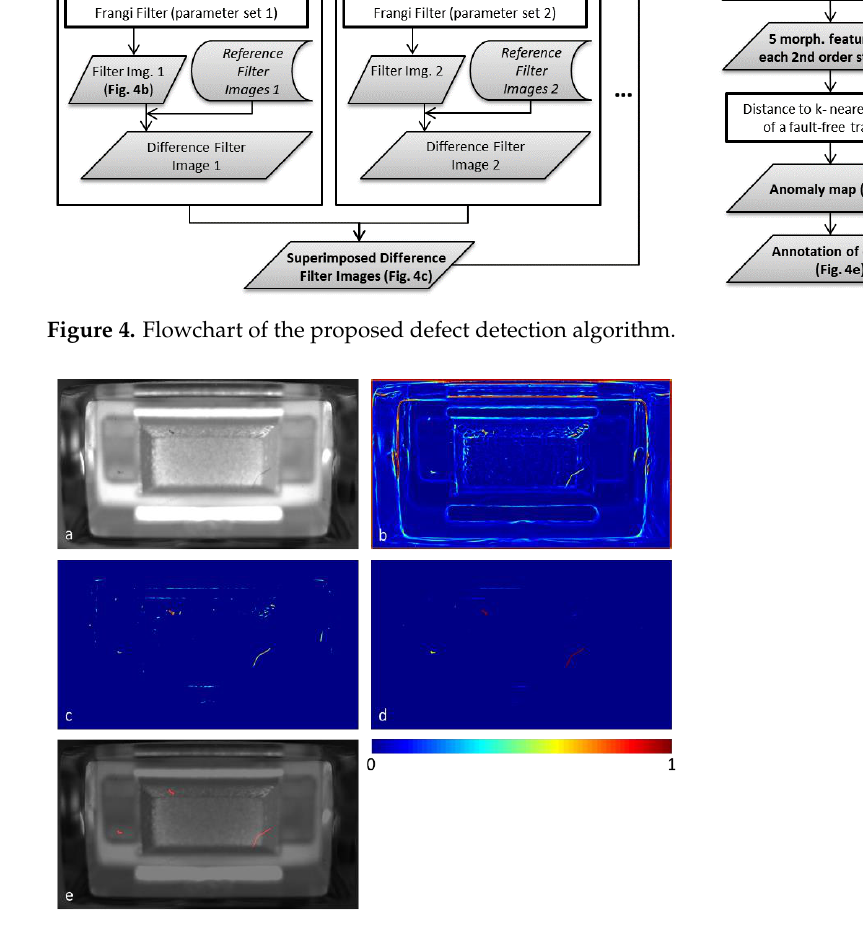
Figure 5. Inspection of a defective illuminant part with of the proposed inspection algorithm (in- terim results). ( a ) Shows the input image after registration, ( b ) the Frangi filtered image, and ( c ) the difference filter image based on the filtered input image and the filtered golden samples. The anomaly map ( d ) shows the anomaly score for every connected component. In ( e ), structures that are classified as defective according to a predefined threshold for the anomaly score are superposed on the input image. In the lower right, the scale bar of the false color images is